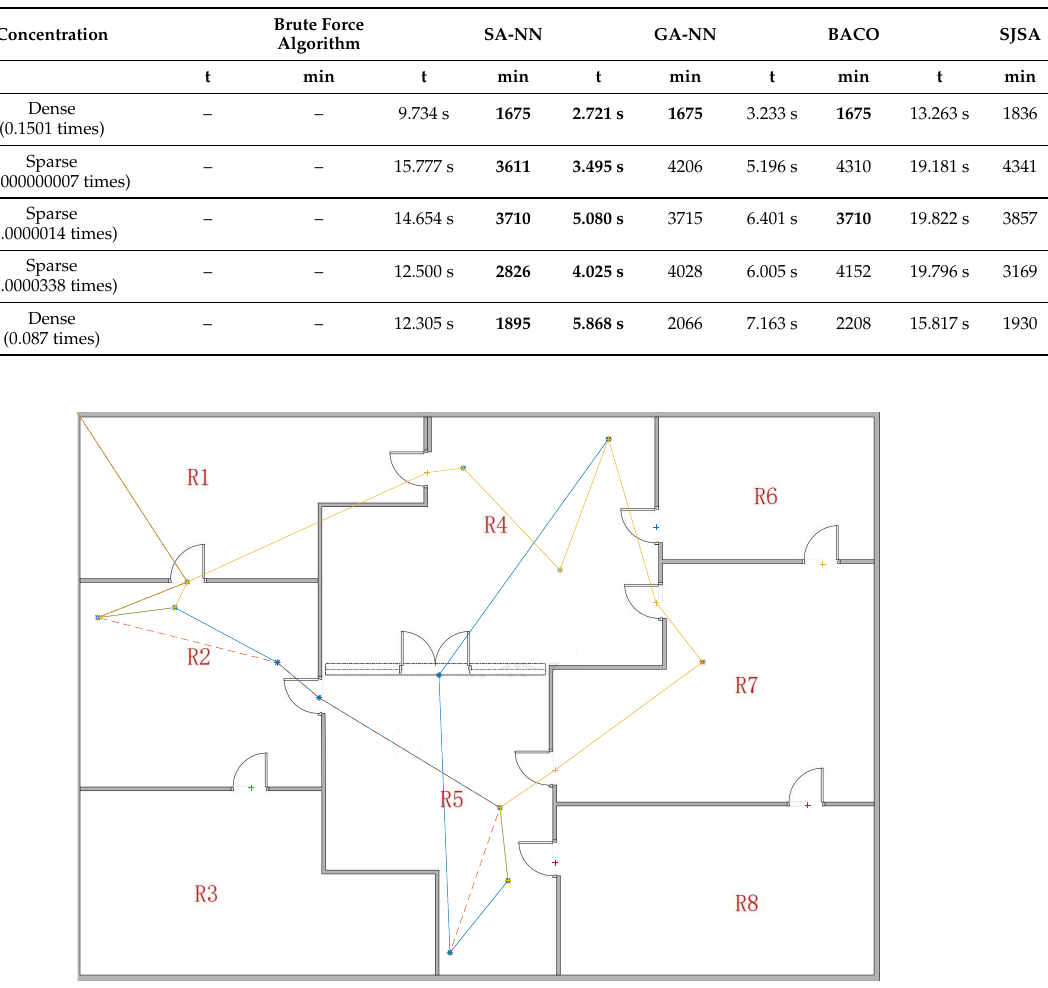
Figure 5. The routes of the UAVs in Instance